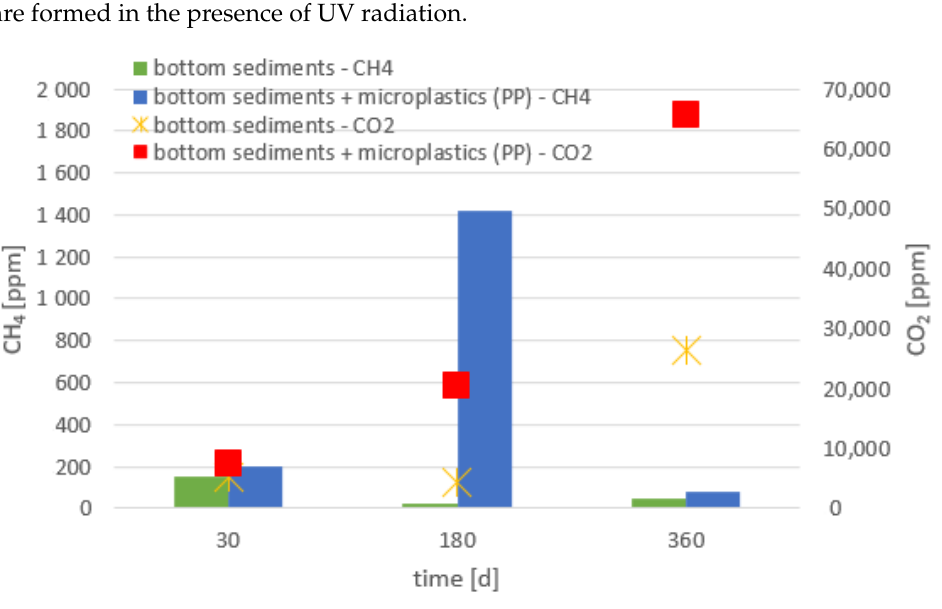
Figure 3. CH 4 and CO 2 emissions from PVC (foil).